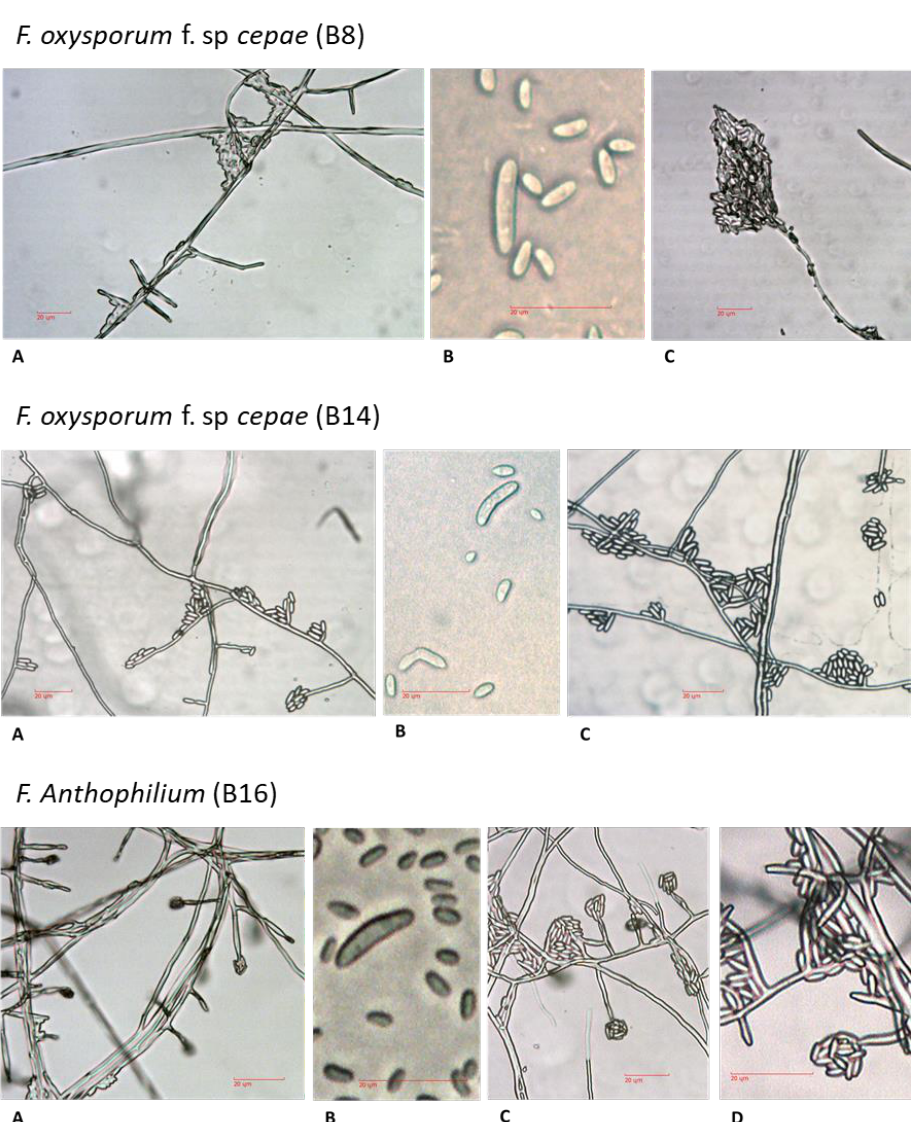
Figure 5. Microscopic characterization of the Fusarium spp. isolates. The Fusarium isolates grew on PDA medium for five days at 28 ± 1 °C in the dark. The slide culture technique was used [15]. Samples were studied using a light microscope (magnification 250:1, no stain used). ( A ) Hyphae. ( B ) Microconidia (small cells) and macroconidia (large cells). Conidia germinated via monopolar or bipolar germ tubes. ( C ) Conidiophores (monophialide) carry large quantities of microconidia on its false head. ( D ) Magnification of the conidiophores. Scale bars represent 20 µm.